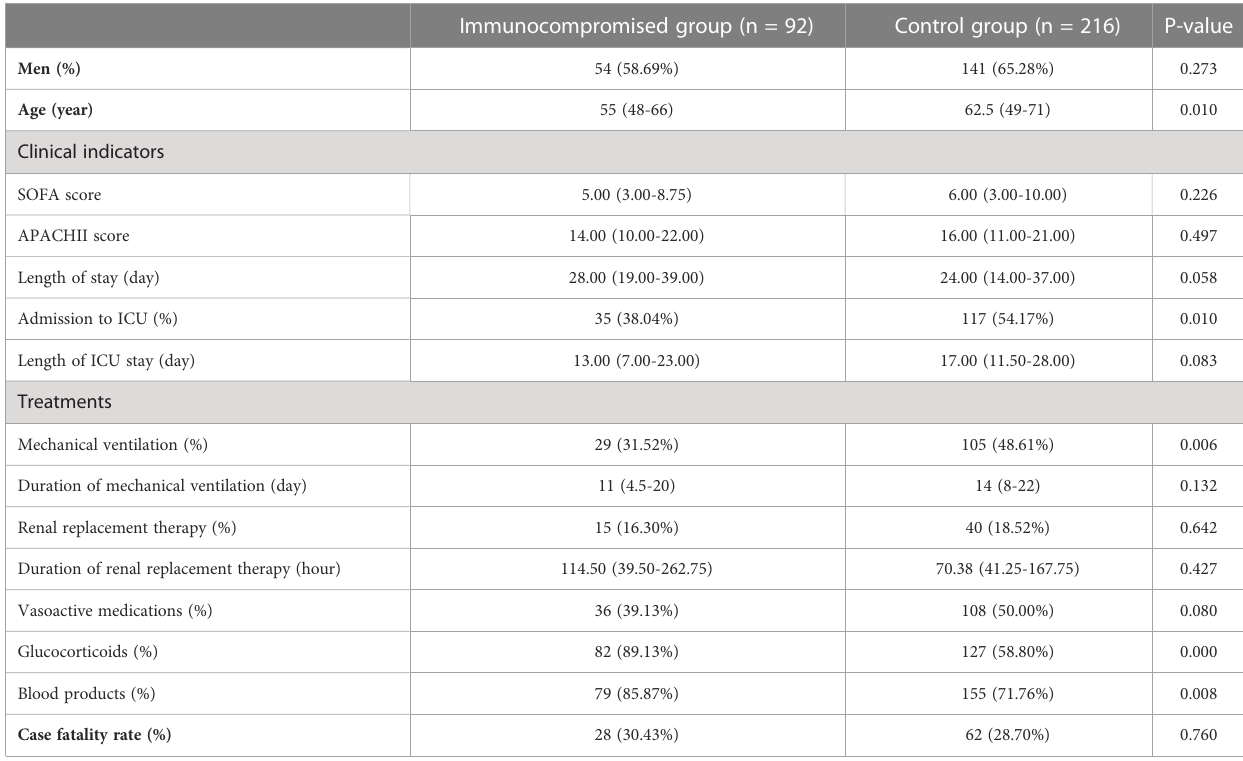
TABLE 1 The basic clinical information of